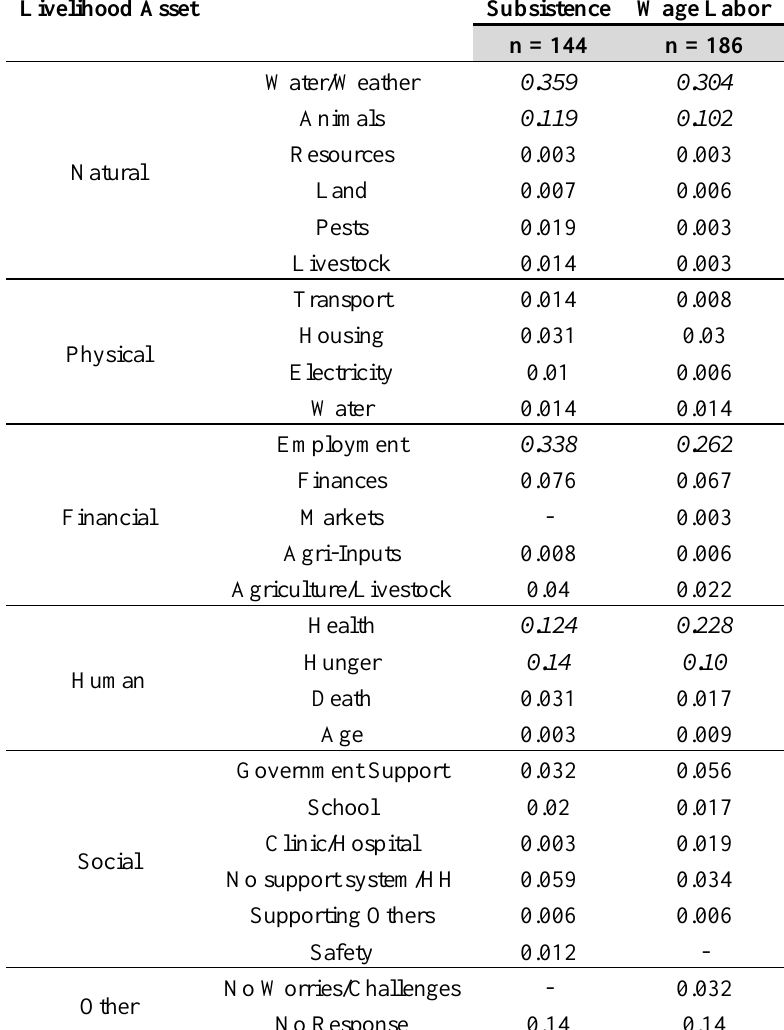
Table 6. Risk index values subset by employment status. Employment is defined as economic activities from which a salary is drawn. Meaning those working in agricultural pursuits or without jobs were classified as